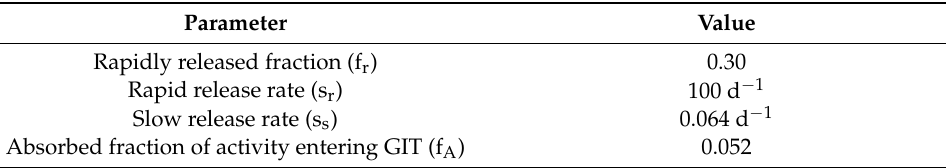
Table 4. Biokinetic model absorption parameter